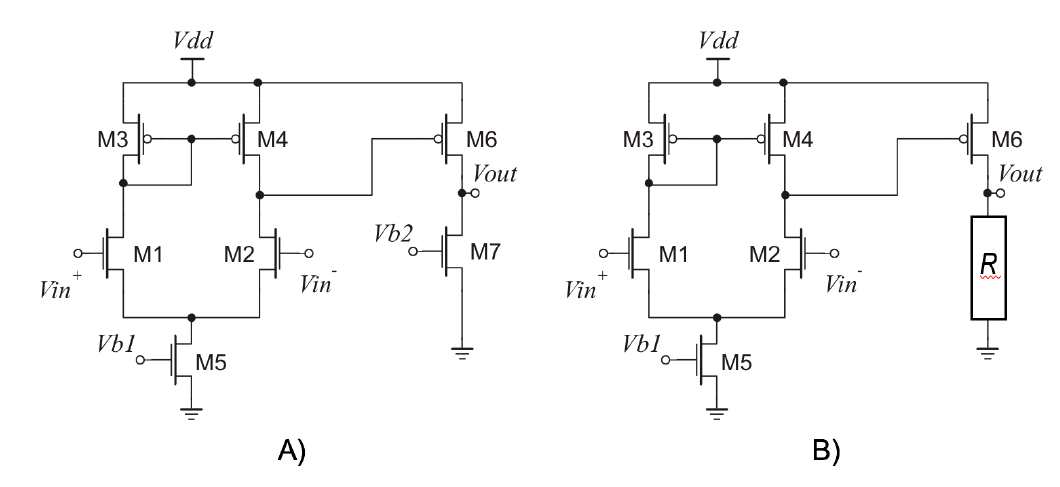
Figure 18. Schematic ofthe Miller amplifier without the RC network for the frequency compensation: ( A ) with active load, ( B ) with resistive